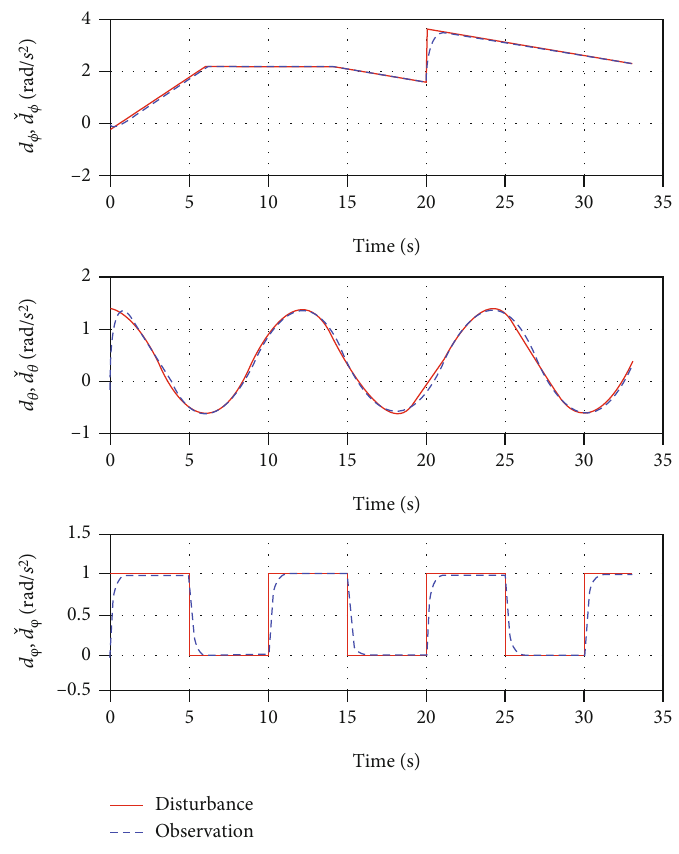
Figure 15: Estimations of external